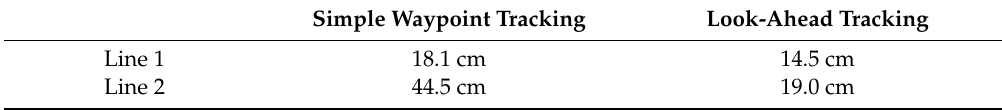
Figure 7. Trajectories of the autonomous mobile GCP obtained from two different path-tracking methods, the waypoint tracking method ( a ) and look-ahead tracking method ( b ), following a U-shape path on the ground. Table 1. Comparison of RMSEs between the waypoint tracking and look-head tracking methods.